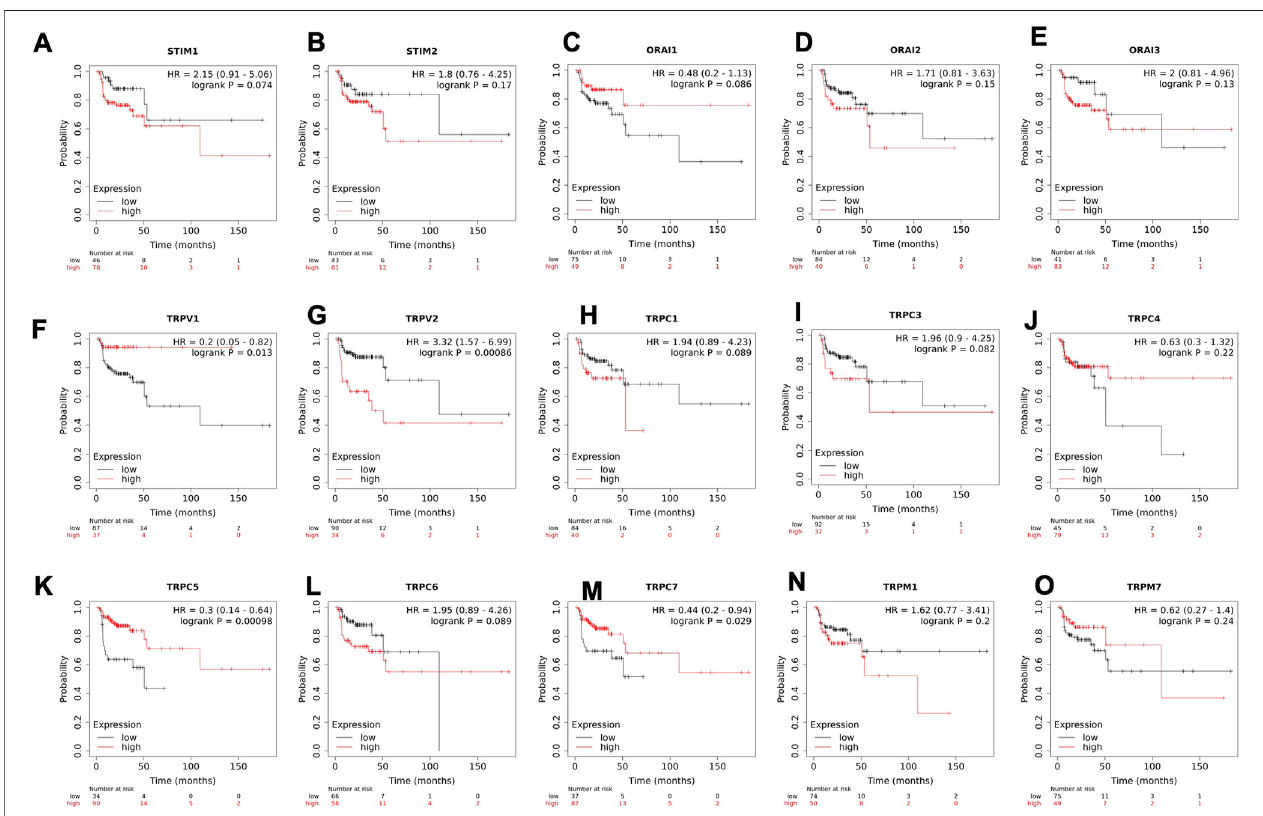
FIGURE 7 | Altered mRNA expression of SOCs lead to poor relapse survival of HNSC patients. (A-O) Kaplan-meier plot for relapse free survival of head and neck cancerpatientswithaltered expressionofSOCsareshown.ThesurvivalprobabilityversustimeforhighandlowexpressionofSOCsareshown.Inset-Hazardratio(HR) with 95% con fi dence interval and logrank p value are shown. The number of patients at risk during each time interval for both high and low expression of SOCs is represented below the